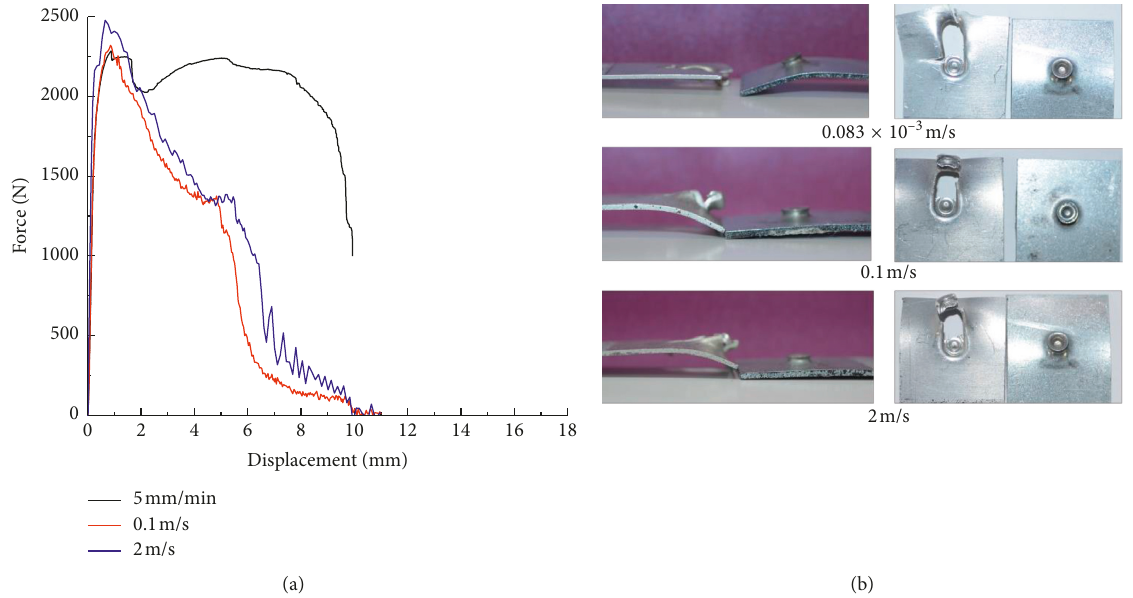
Figure 6: Dynamic lap-shear tests of SPR joints: (a) force-displacement curves and (b) failure modes at three